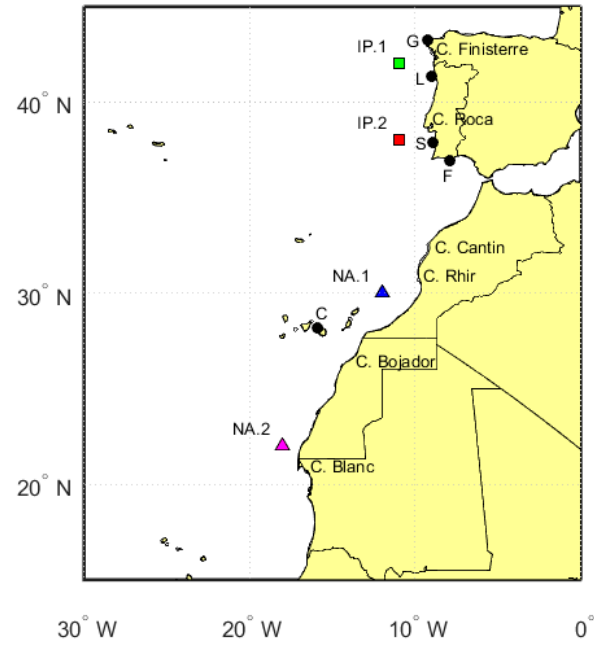
Figure 1. Map with buoy positions with black dots: G-Galicia Villano (43°28 ′ 48 ″ N–009°13 ′ 12 ″ W), L- black dots: G-Galicia Villano Leixões (41°19 ′ N–008°59 ′ W), S-Sines (37°55 ′ 16 ″ N–008°55 ′ 44 ″ W), F-Faro (36°54 ′ 17 ″ N–007°53 ′ 54 ″ W), (43 ◦ 28 (cid:48) 48 (cid:48)(cid:48) N–009 ◦ 13 (cid:48) 12 (cid:48)(cid:48) W), L-Leix õ es (41 ◦ 19 (cid:48) N–008 ◦ 59 (cid:48) W), S-Sines (37 ◦ 55 (cid:48) 16 (cid:48)(cid:48) N–008 ◦ 55 (cid:48) 44 (cid:48)(cid:48) W), and C-Canary Gran Canaria (28°10 ′ 48 ″ N–015° 49 ′ 12 ″ W), and key positions along the west coast of F-Faro (36 ◦ 54 (cid:48) 17 (cid:48)(cid:48) N–007 ◦ 53 (cid:48) 54 (cid:48)(cid:48) W), and C-Canary Gran Canaria (28 ◦ 10 (cid:48) 48 (cid:48)(cid:48) N–015 ◦ 49 (cid:48) 12 (cid:48)(cid:48) W), Iberia Peninsula (green and red triangles: IP.1, and IP.2, at 42° N–11° W, and 38° N–11° W, and key positions along the west coast of Iberia Peninsula (green and red triangles: IP.1, and IP.2, respectively) and the north-west coast of Africa (blue and magenta squares: NA.1, and NA.2, at 30° at 42 ◦ N–11 ◦ W, and 38 ◦ N–11 ◦ W, respectively) and the north-west coast of Africa (blue and magenta N–12° W, and 22° N–18° W, respectively). squares: NA.1, and NA.2, at 30 ◦ N–12 ◦ W, and 22 ◦ N–18 ◦ W,